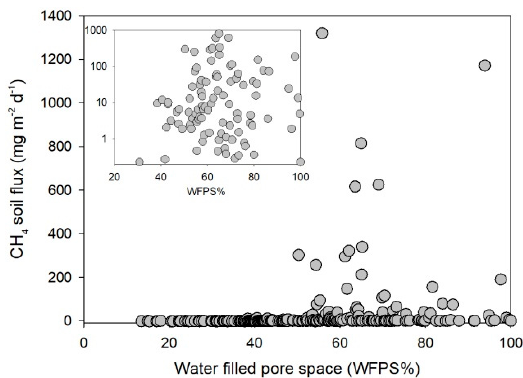
Figure 6. CH 4 fluxes plotted vs. soil water-filled pore space (%) measured inside the chambers after the gas sampling, in the downhill area. In the small box, fluxes are reported on a log scale to evidence the density of CH 4 fluxes in the range of values 1–100 mg CH 4 m − 2 d − 1 .